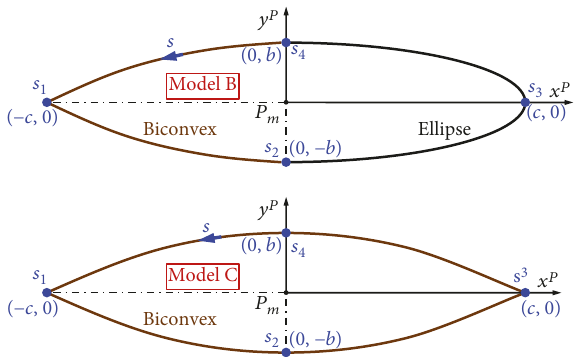
Figure 7: Model B and Model C for